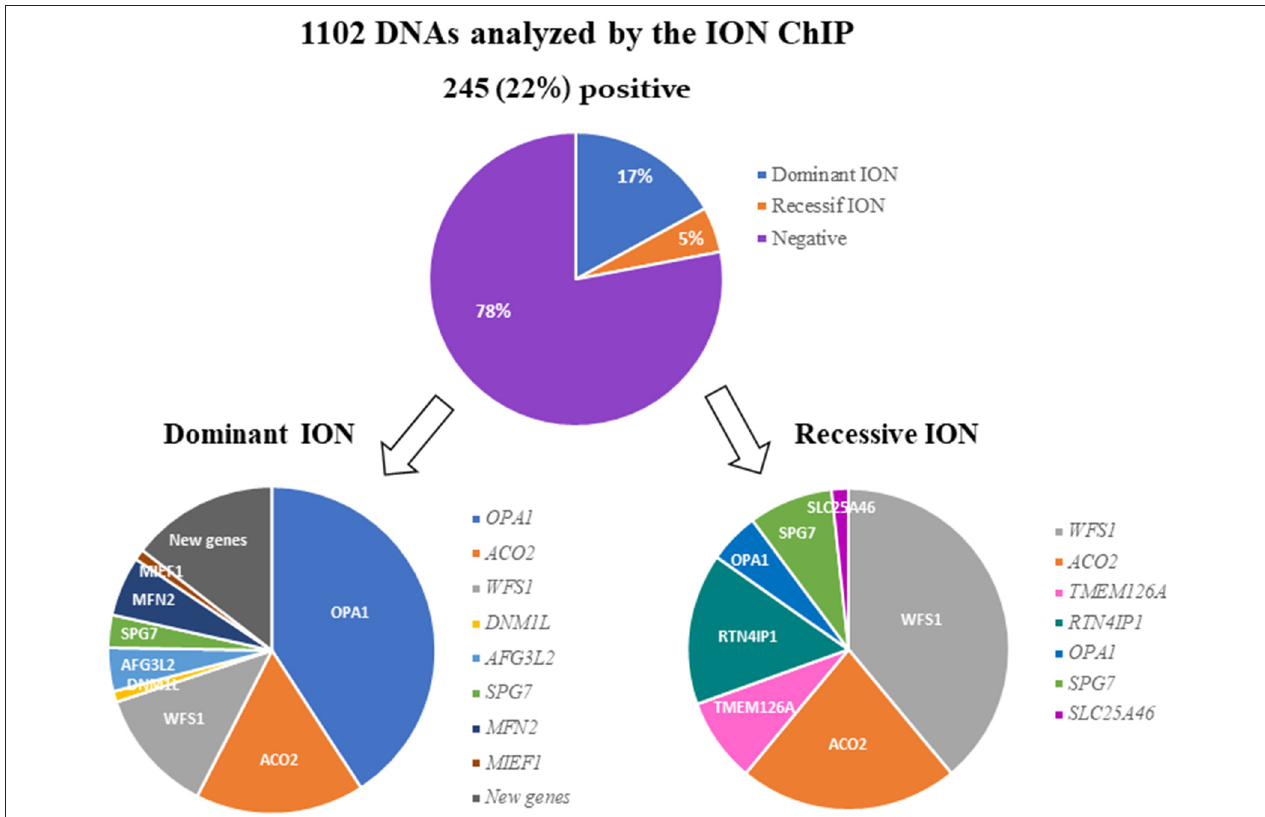
FIGURE 1 | Results of the molecular analysis of 1,102 individuals with ION, using the 22-targeted-gene ION panel. A pathogenic variant was found in 245 (22%) of the DNA samples analyzed. The variants were inherited dominantly or recessively in 186 and 59 cases, respectively. The genes involved in dominant and recessive inheritance are